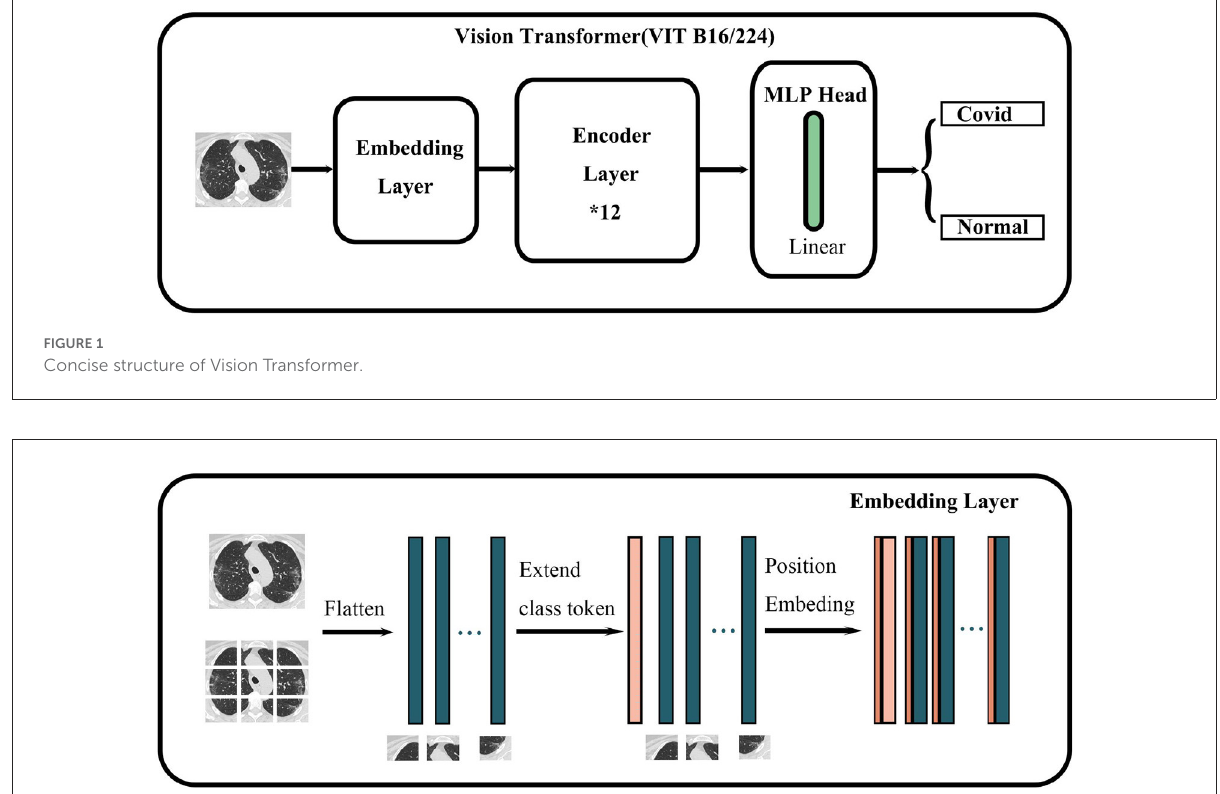
FIGURE2 Structure of embedding layer in Vision Transformer. The darker green wider rectangles represent the flattened feature vector of each block of an image, while the pink wider rectangles represent the feature vectors corresponding to classes, and the brown narrower rectangle represents the spatiotemporal information of the